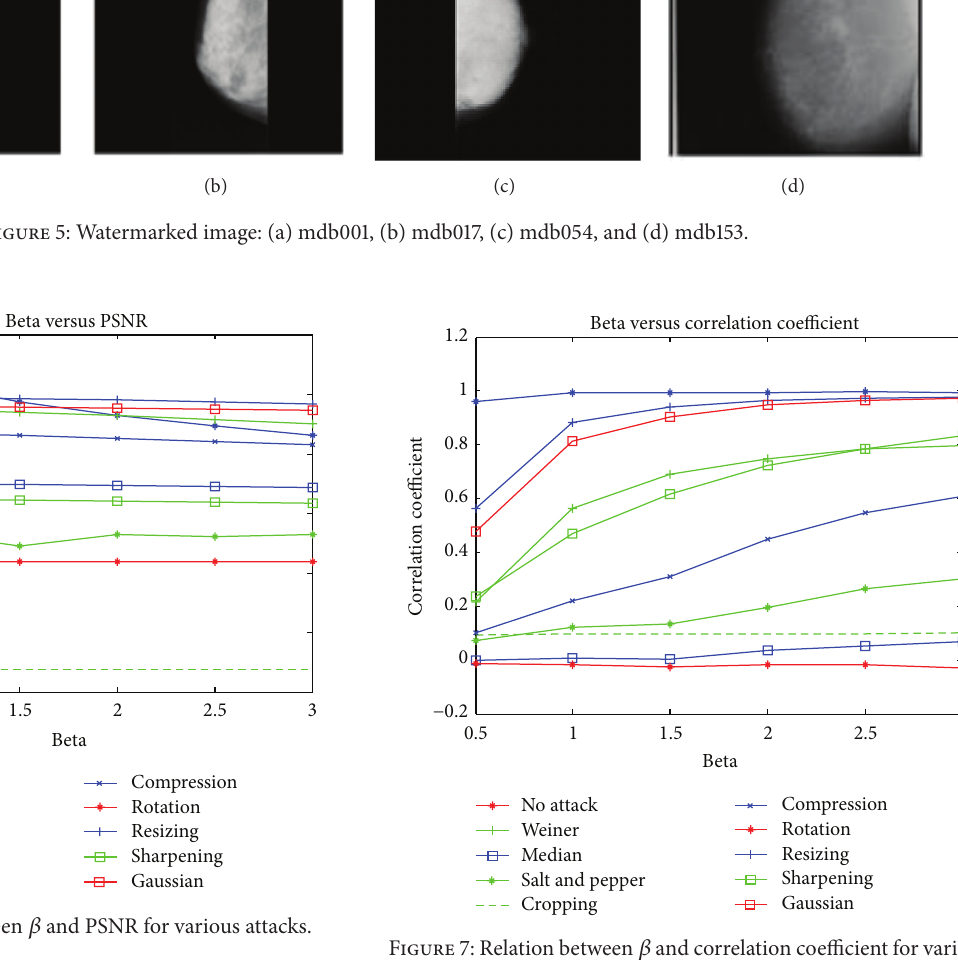
Figure 7: Relation between 𝛽 and correlation coefficient for various